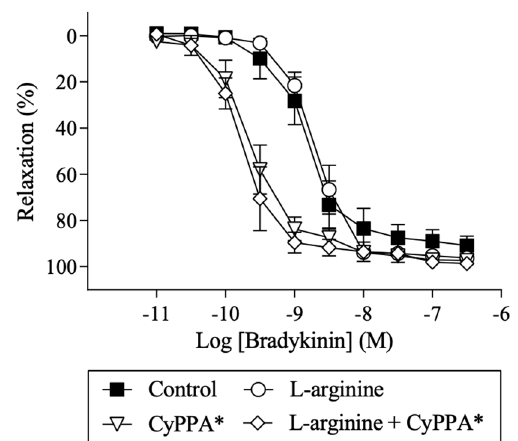
Figure A1. L -arginine-induced relaxation in the absence and presence of CyPPA (6 µM), an opener of SKCa2 and SKCa3 channels, or ADMA (300 µM), an inhibitor of NO synthase, in U46619-contracted porcine retinal arterioles. Data are means ± S.E.M. (n = 5–7). Two-way ANOVA. * p <0.05 vs . control.